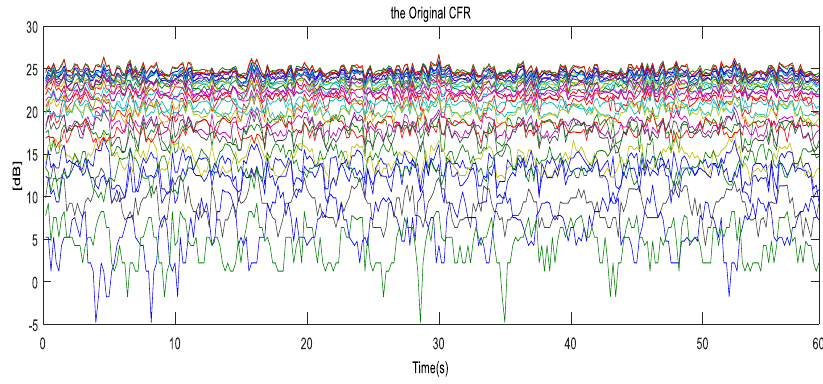
Figure 8. The CFR of all subcarriers for normal breathing.